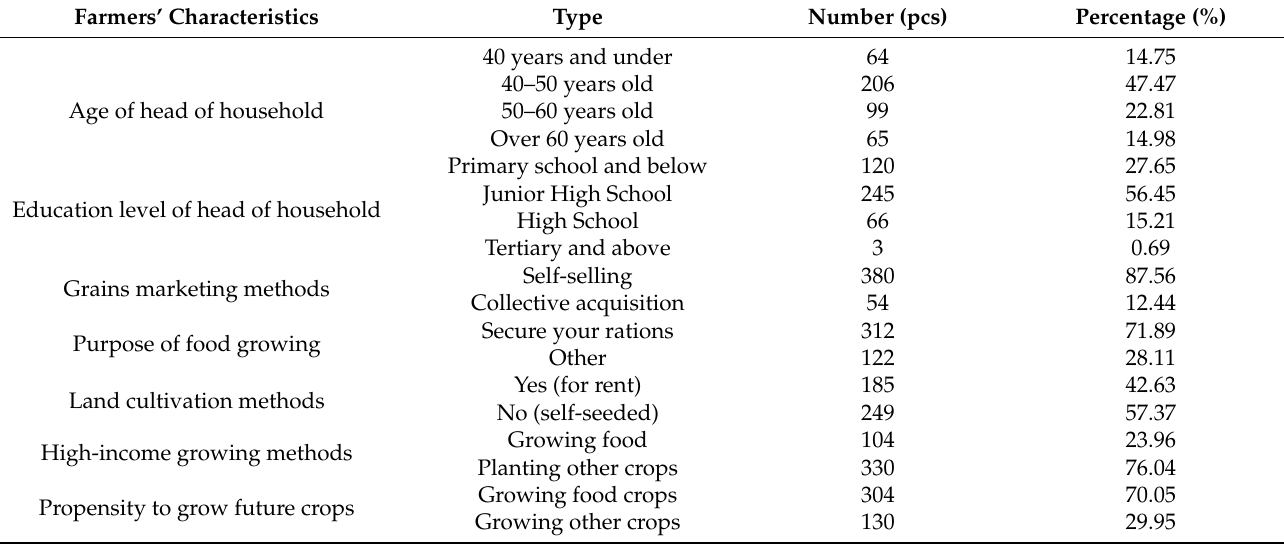
Table 2. Summary statistics of sample farmers’ characteristics and evaluation of food